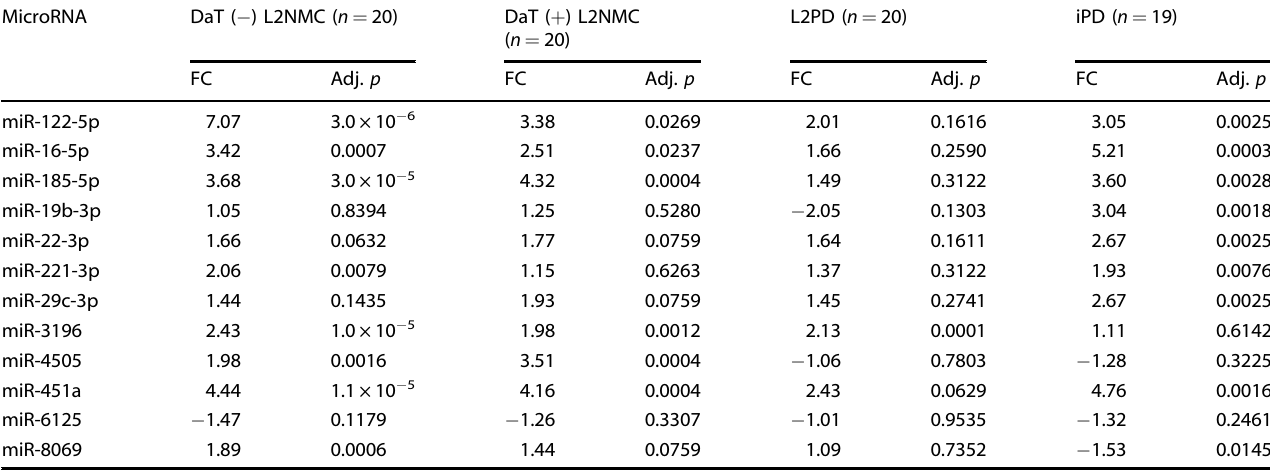
Table 2. RT-qPCR assessment of miRNA levels in serum samples from DaT-negative and DaT-positive L2NMC, L2PD patients and iPD as compared to healthy controls. MicroRNA